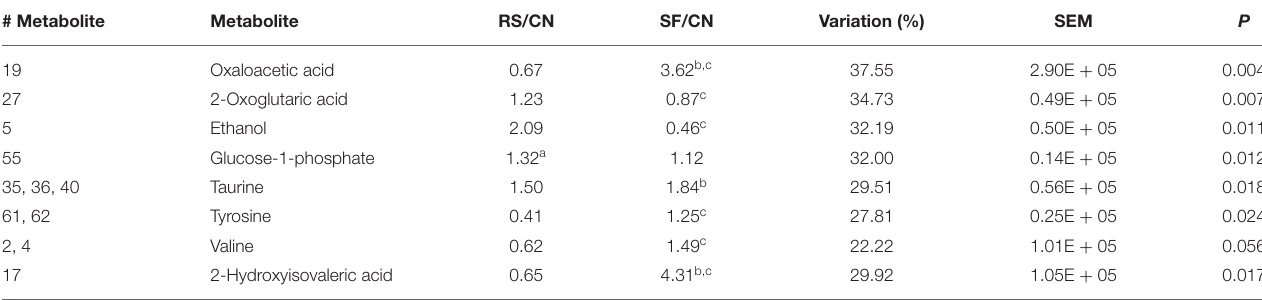
TABLE 2 | Effect of rapeseed oil (RS) and sunflower oil (SF) supplementation on milk metabolites from goats.